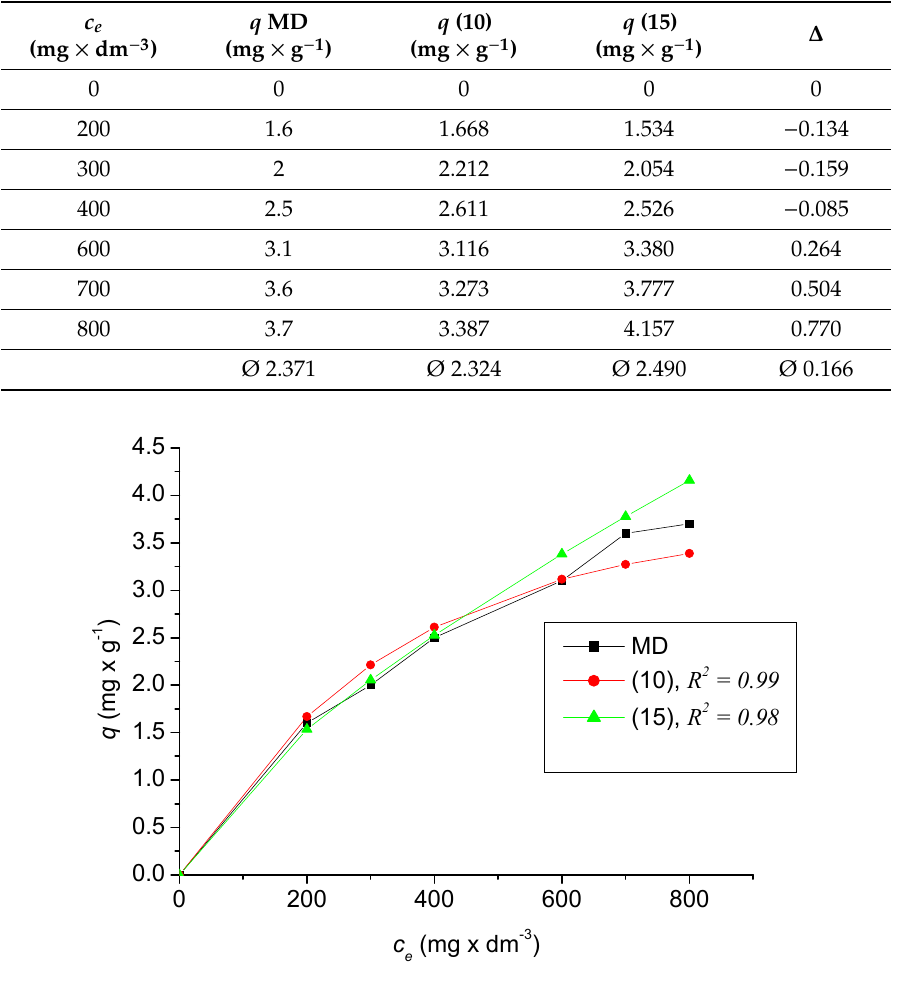
Figure 12. Comparison of dependences of adsorption capacity q on the equilibrium concentration of c e calculated by Equations (10), (15) with measured experimental data (MD).